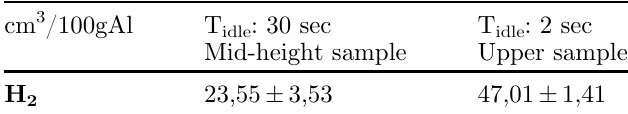
Table 4. Hydrogen content measures.